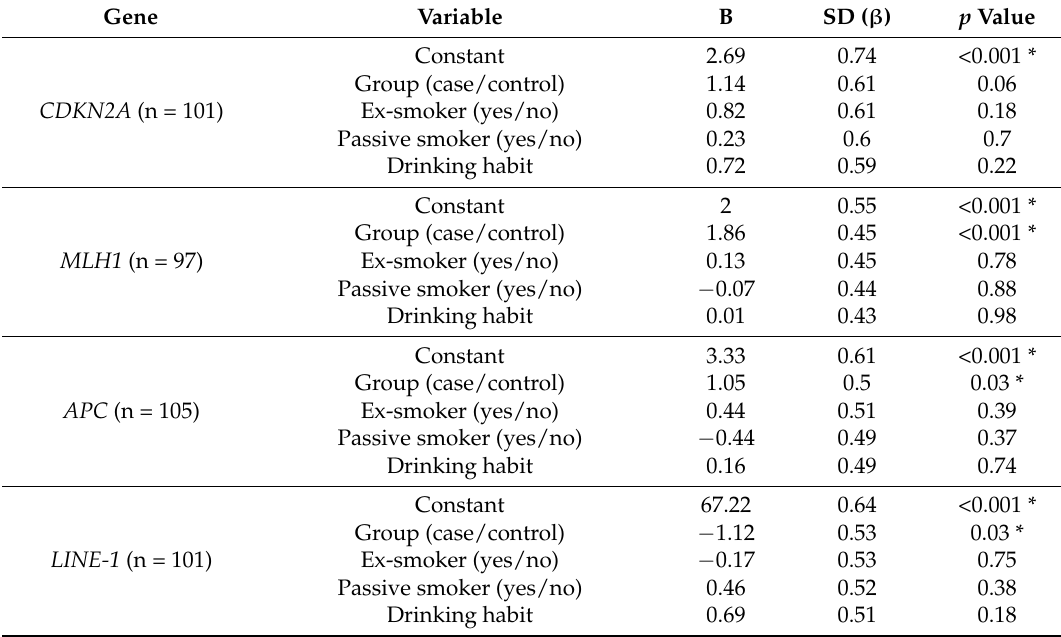
Table 3. Multiple linear regression model for the methylation percentages (%) of the CDKN2A , MLH1 , and APC genes and the LINE-1 repeat sequence in relation to passive smoking, drinking habit, and ex-smoker status (group case × control).